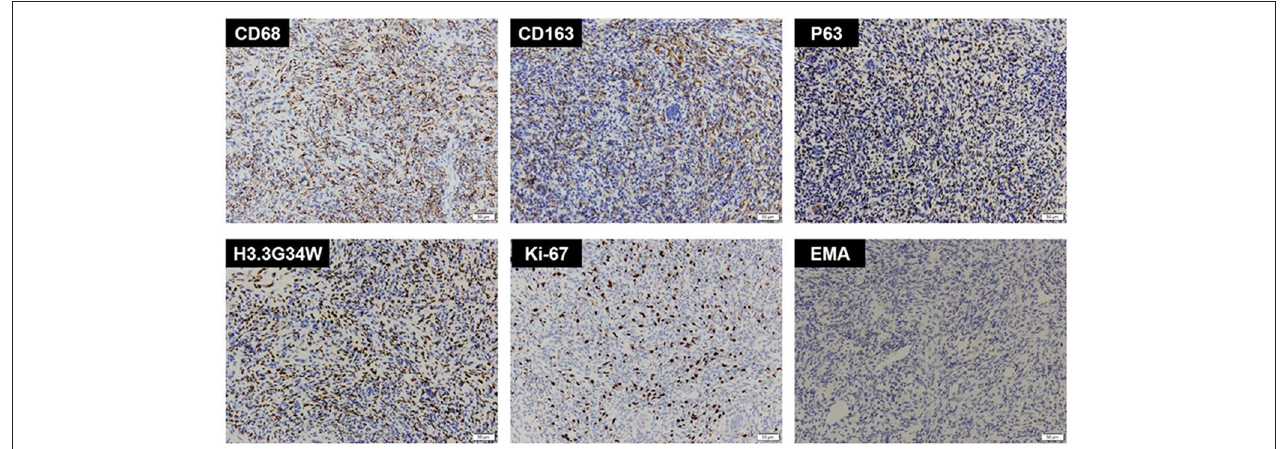
FIGURE 3 | Immunohistochemistry of CD68, CD163, P63, H3.3G34W, Ki-67, and EMA. Immunohistochemistry showed CD68( + ), CD163( + ), P63( + ), H3.3G34W( + ), Ki-67( + , 20%), and